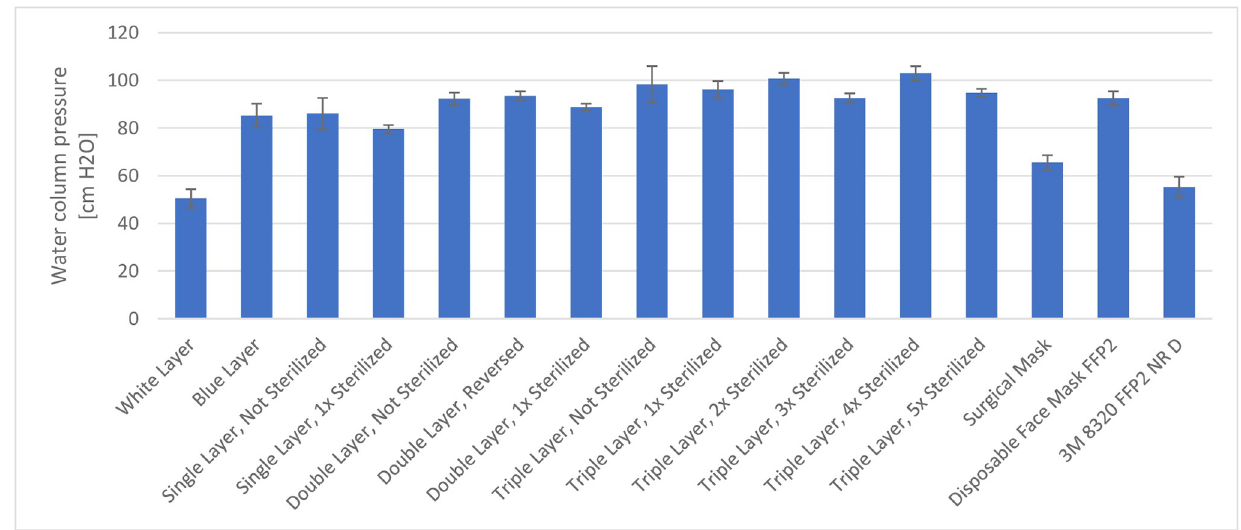
Fig 4. Summary of the results of the water column